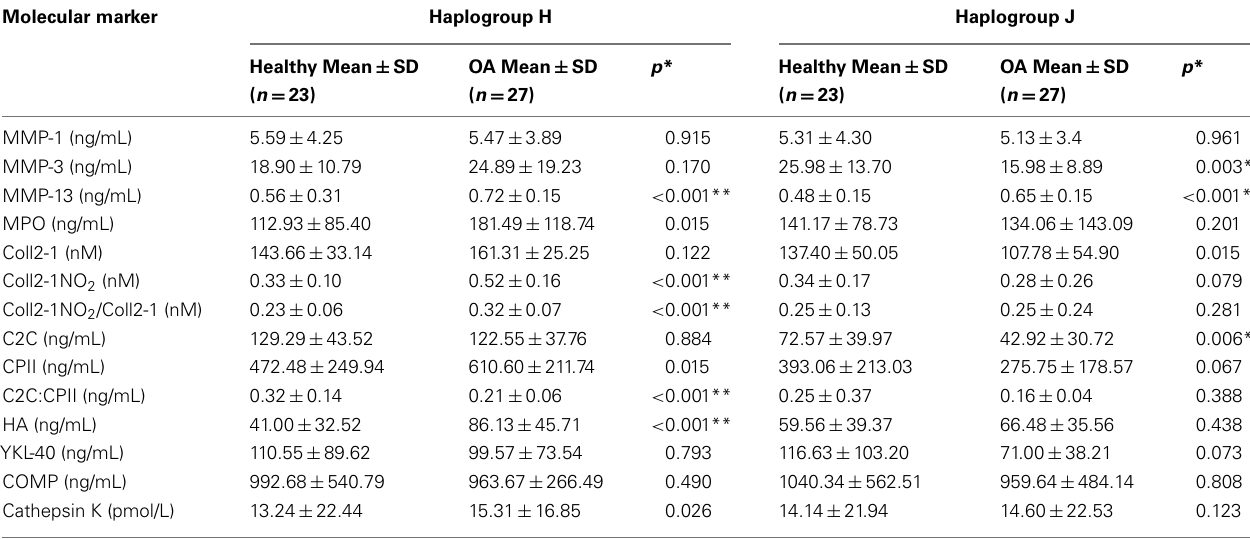
Table 1 | Univariate analysis of the biomarkers for haplogroups H and J. Molecular marker